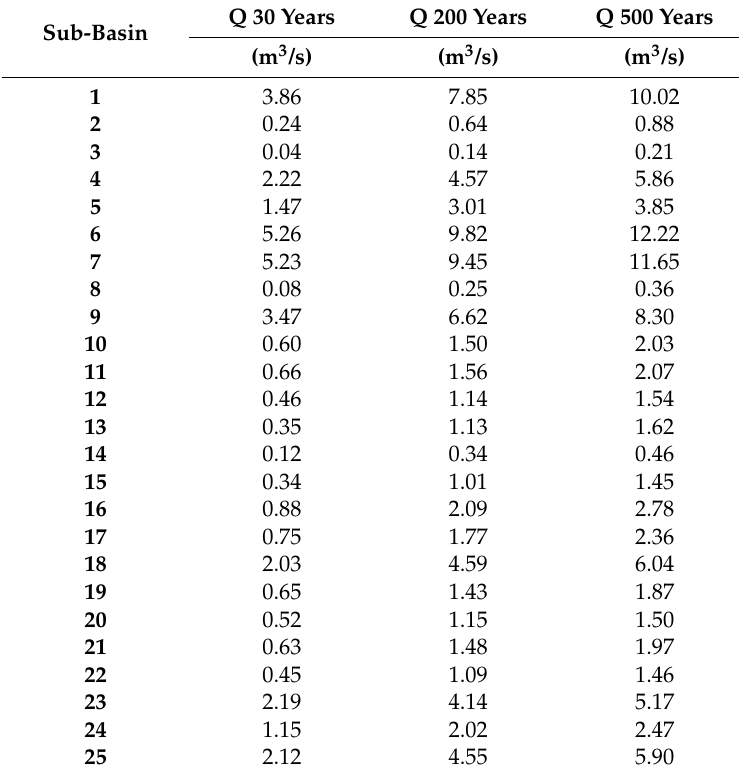
Table 2. Flow rates for several return